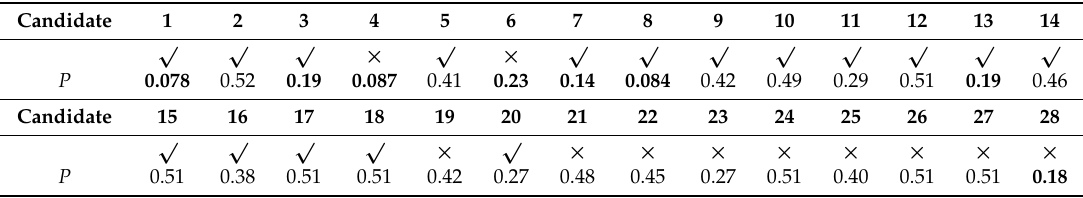
Table 6. Preliminary discrimination results and confidence probabilities by CoD (confidence discrimination based on features) for test image ID 1 ( √ represents ship target and × represents false alarms, P is the confidence probability).